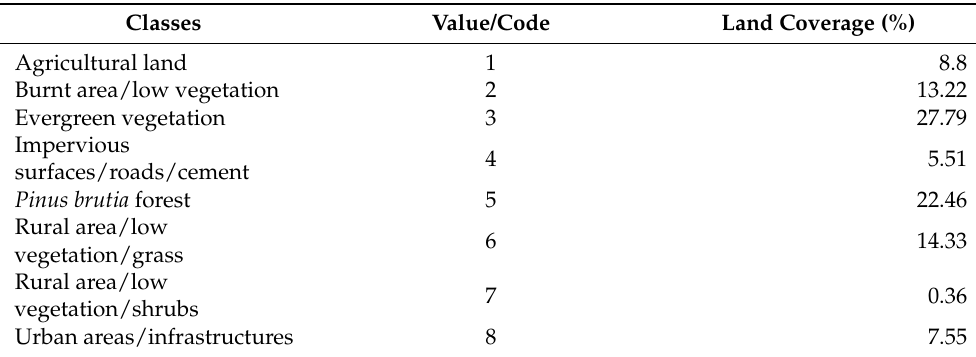
Table 1. Land cover types in the peri-urban area of Thessaloniki (in the 500 m buffer outside city borders) WUI category I.